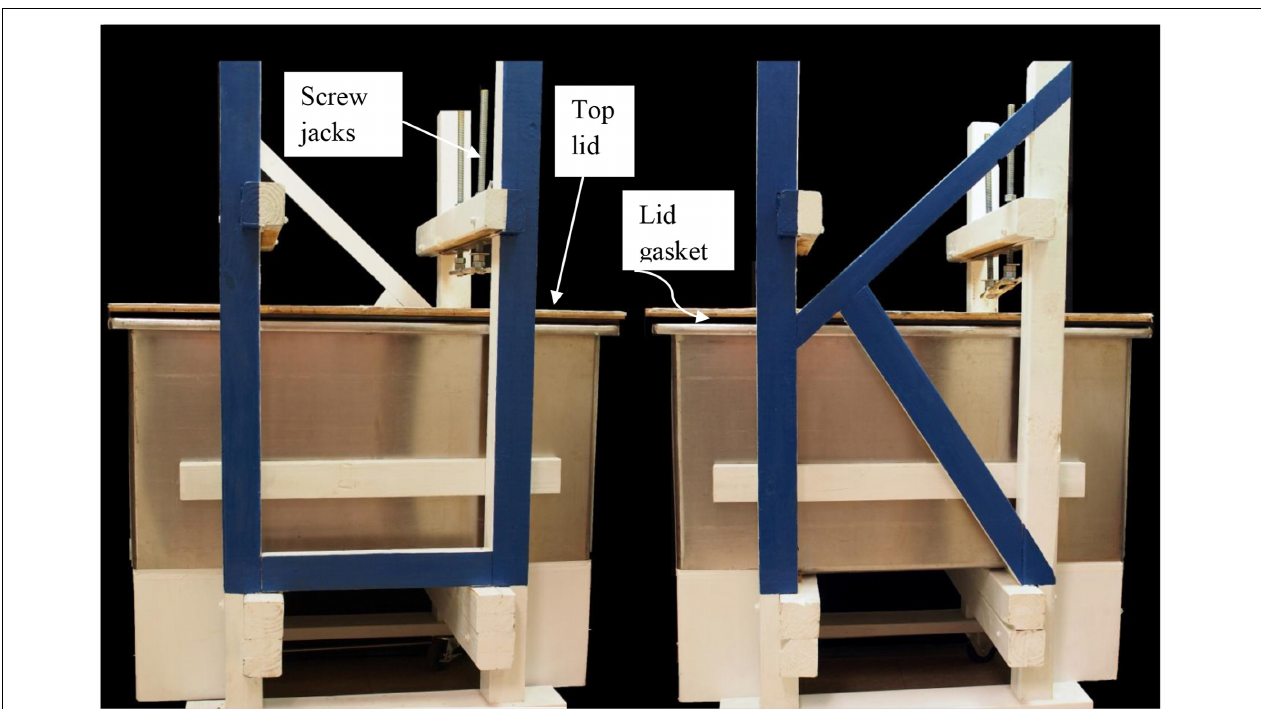
FIGURE 1 | Front and rear view of tub extractor that holds 150kg powdered